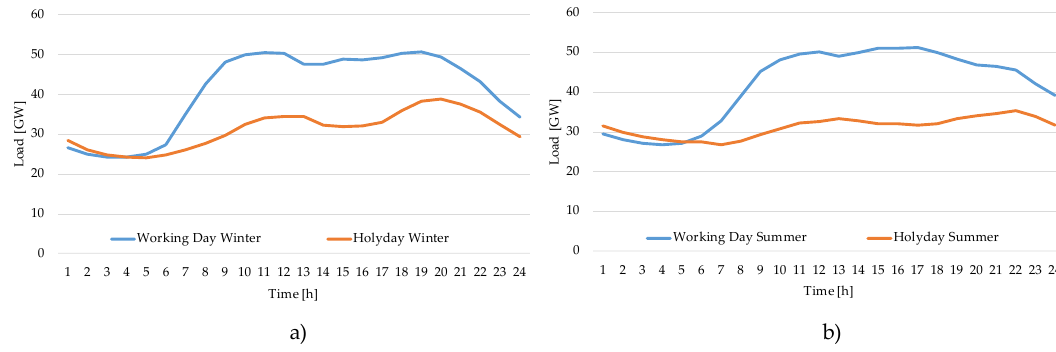
Figure 2. Subdivision among sectors of the energy consumed in Italy.